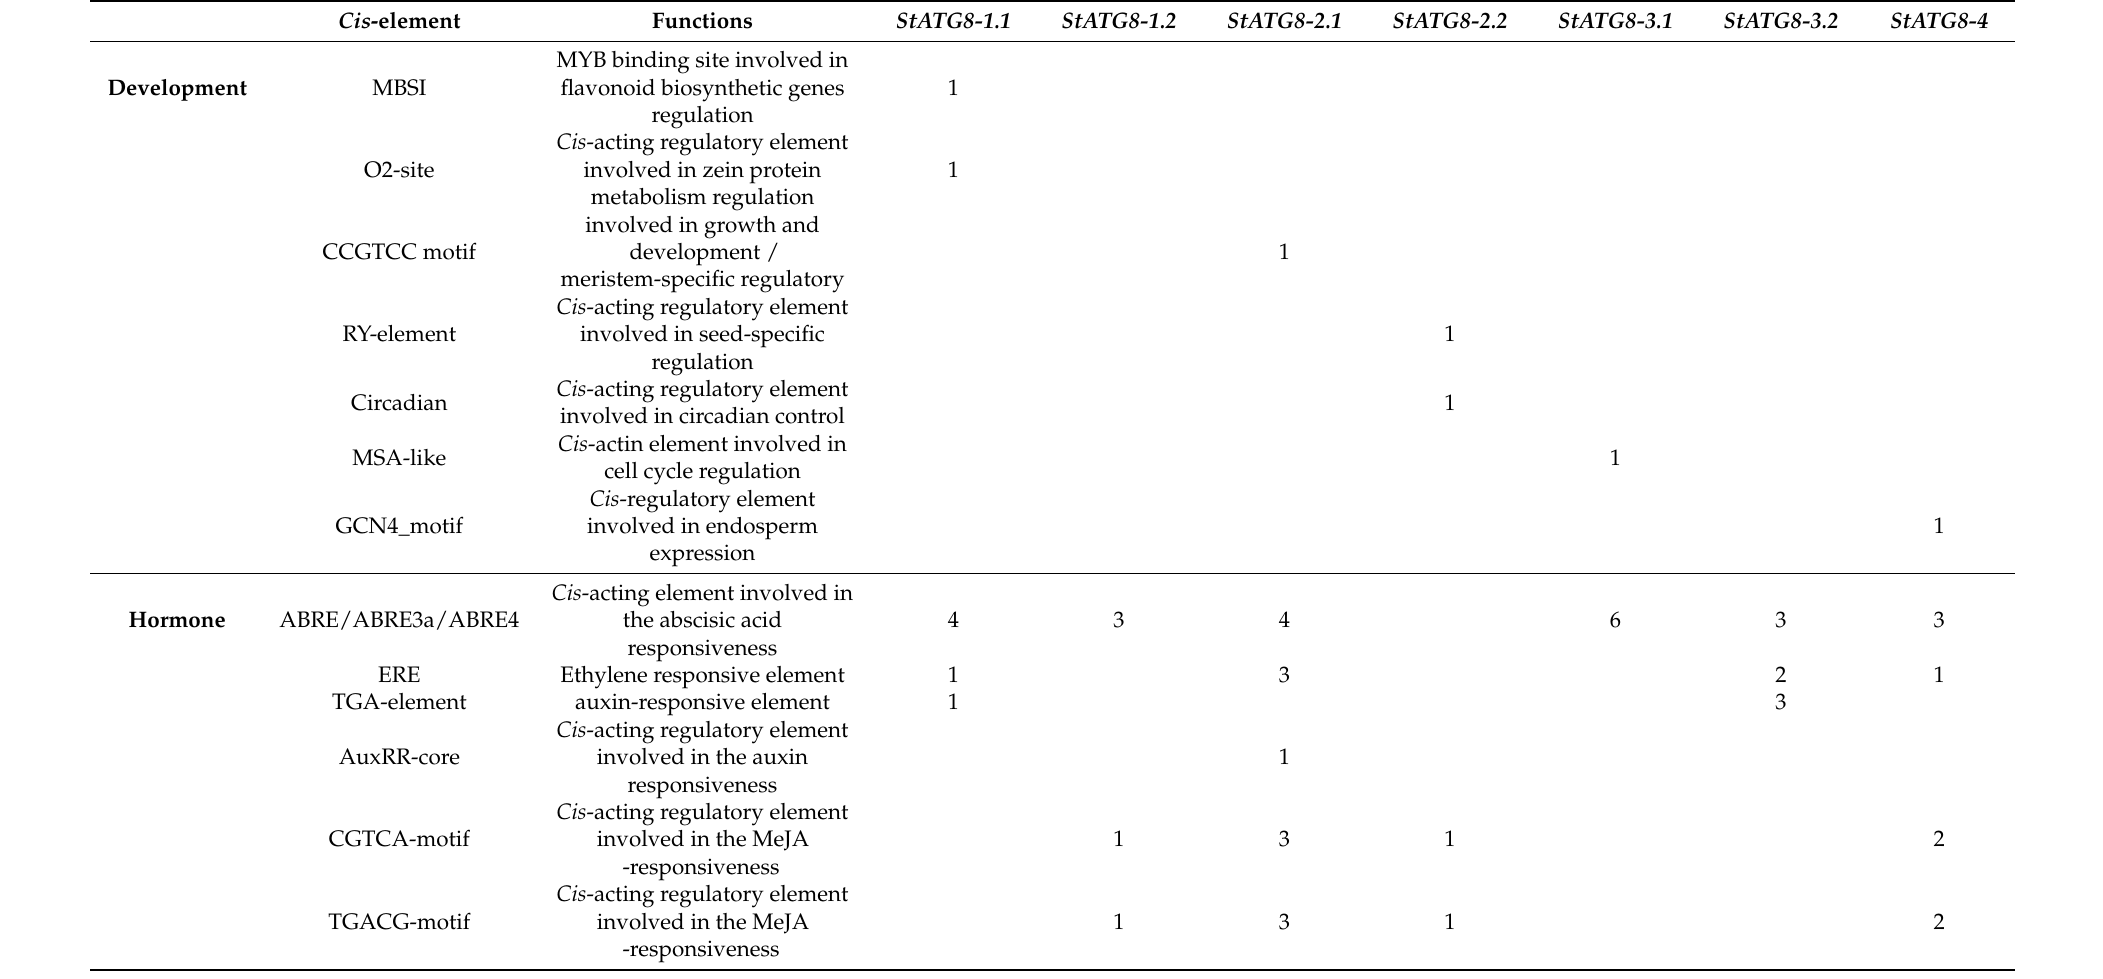
Table 1. Cis -acting regulatory element analysis in potato StATG8 promoter